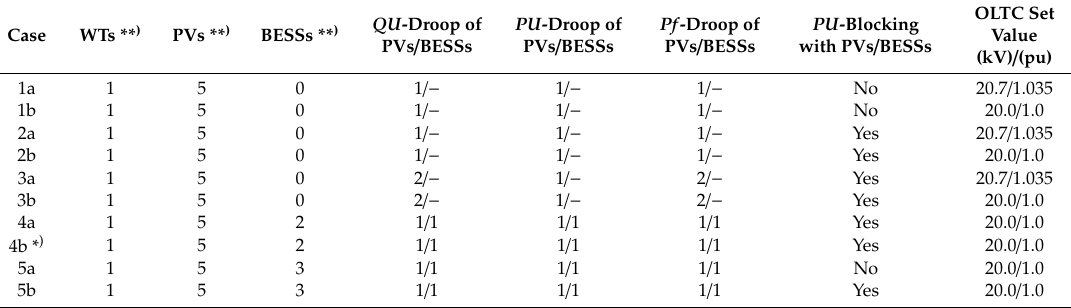
Table 2. Simulation study cases, very low load in all cases (see Figure 2).